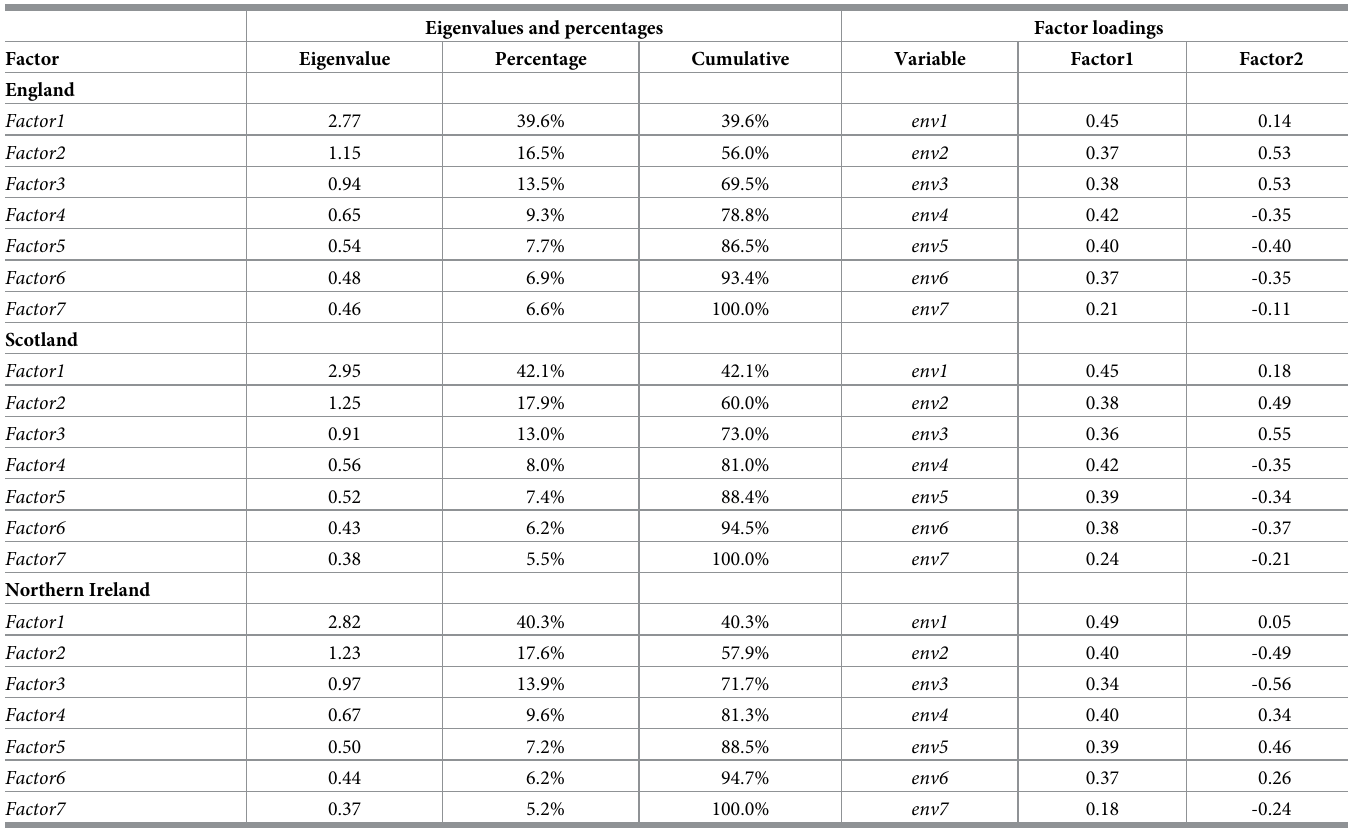
Table 5. Exploratory factor